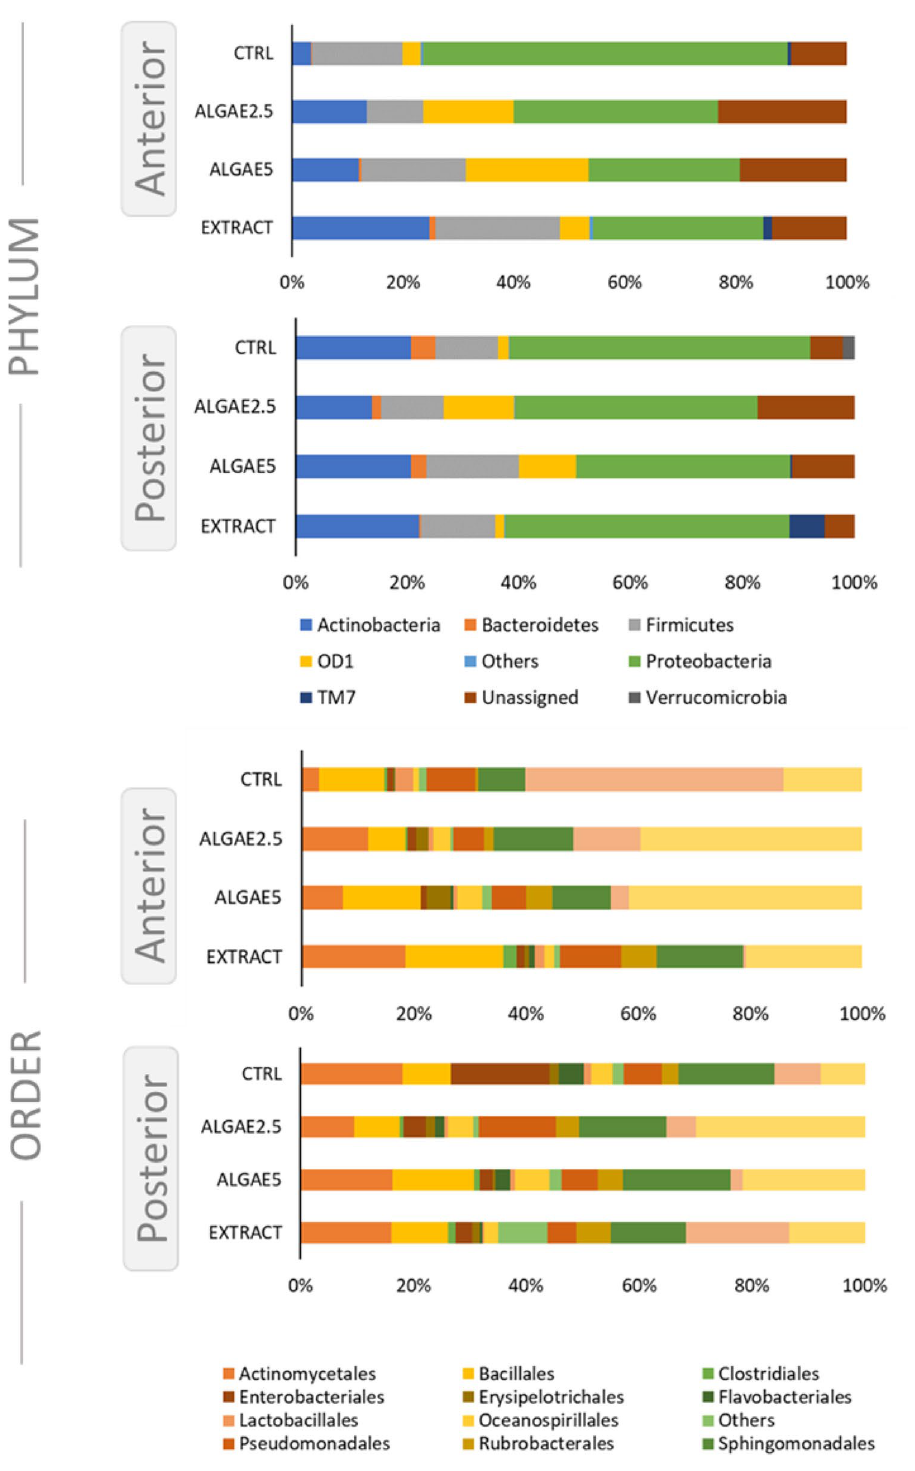
Figure 3. Relative phyla (upper charts) and order (lower charts) abundance of European seabass gut microbial communities. Fish were fed a basal diet with no supplement (CTRL) or supplemented with Gracilaria gracilis powdered biomass at 2.5% (ALGAE2.5), at 5% (ALGAE5) or with the seaweed extract at 0.35% inclusion rate